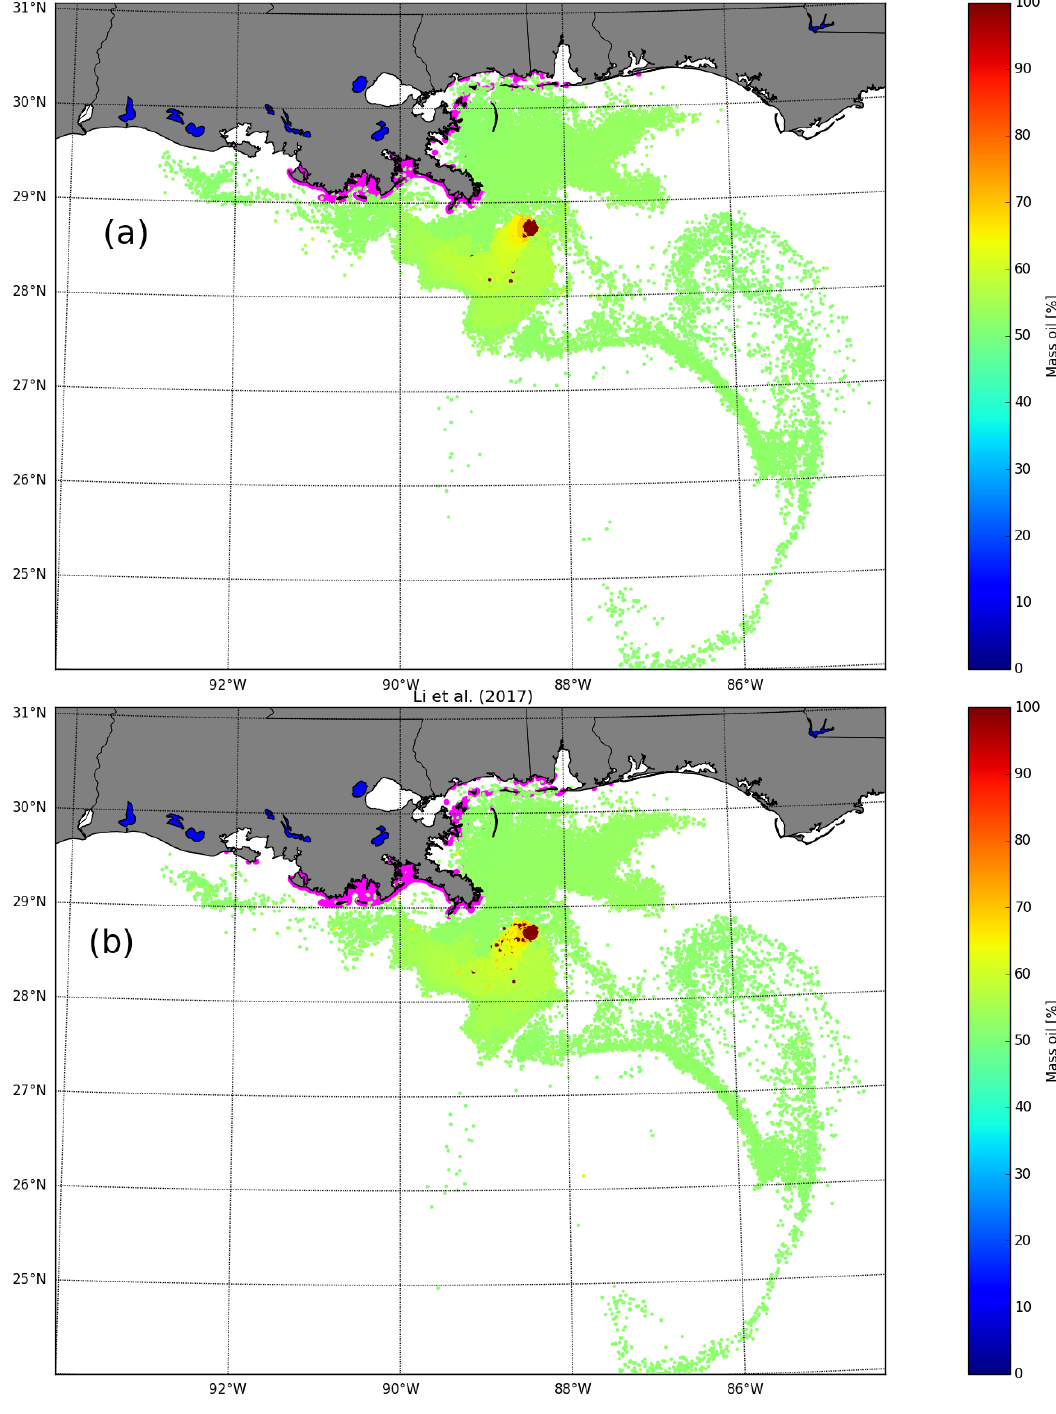
Figure 4. OpenOil simulation for 20–27 May 2010, using the Delvigne and Sweeney [46] oil droplet size distribution ( a , 13.2% stranded oil), and the Li et al. [42] distribution ( b , 12.8% stranded oil). Only surface oil elements are shown. Patch colors are the fraction of mass left in the elements. Magenta areas indicate stranded